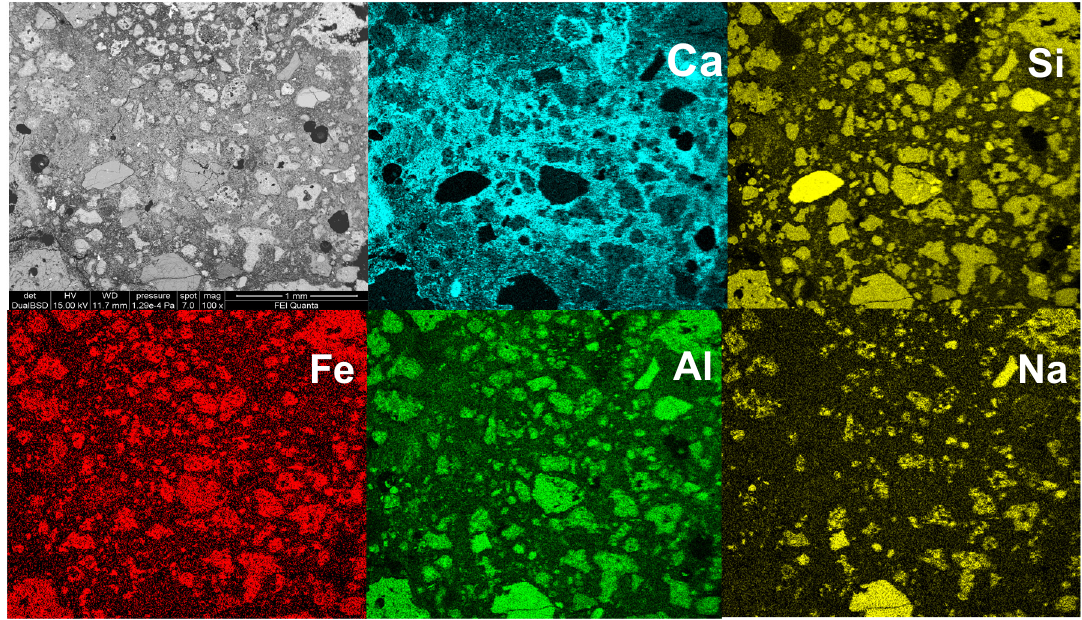
Figure 13. BSE image and X-Ray maps of sample M4.